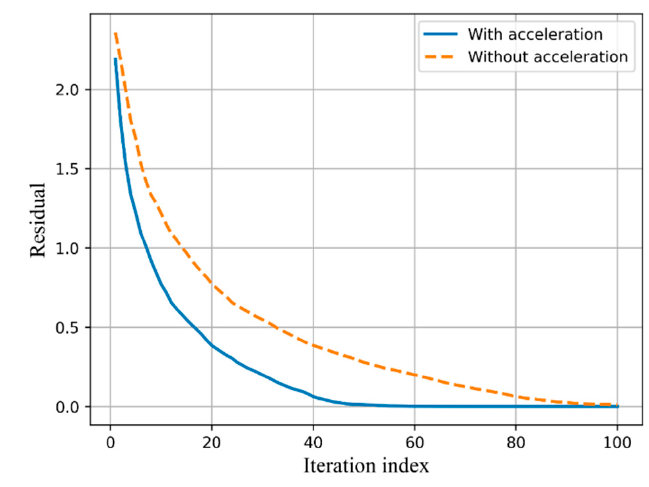
Figure 6. Change in residual versus iteration index.